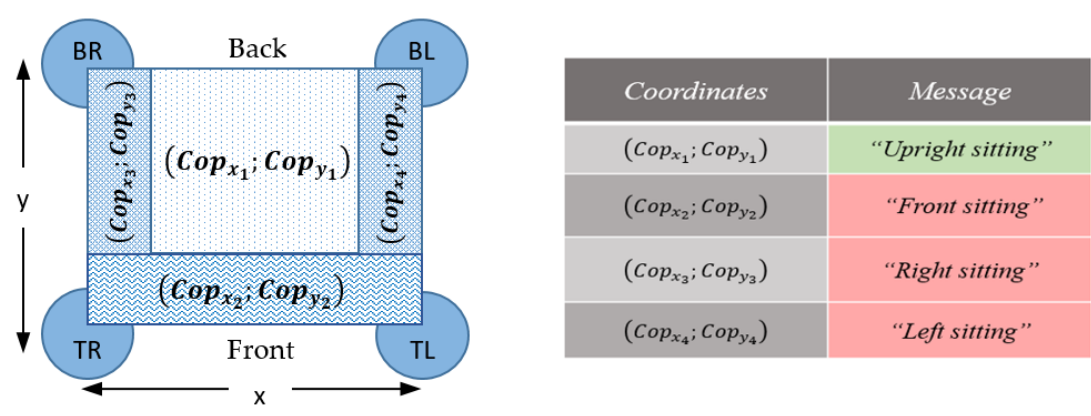
Figure 7. Sitting posture zones and corresponding Center of Pressure (Cop) coordinates.